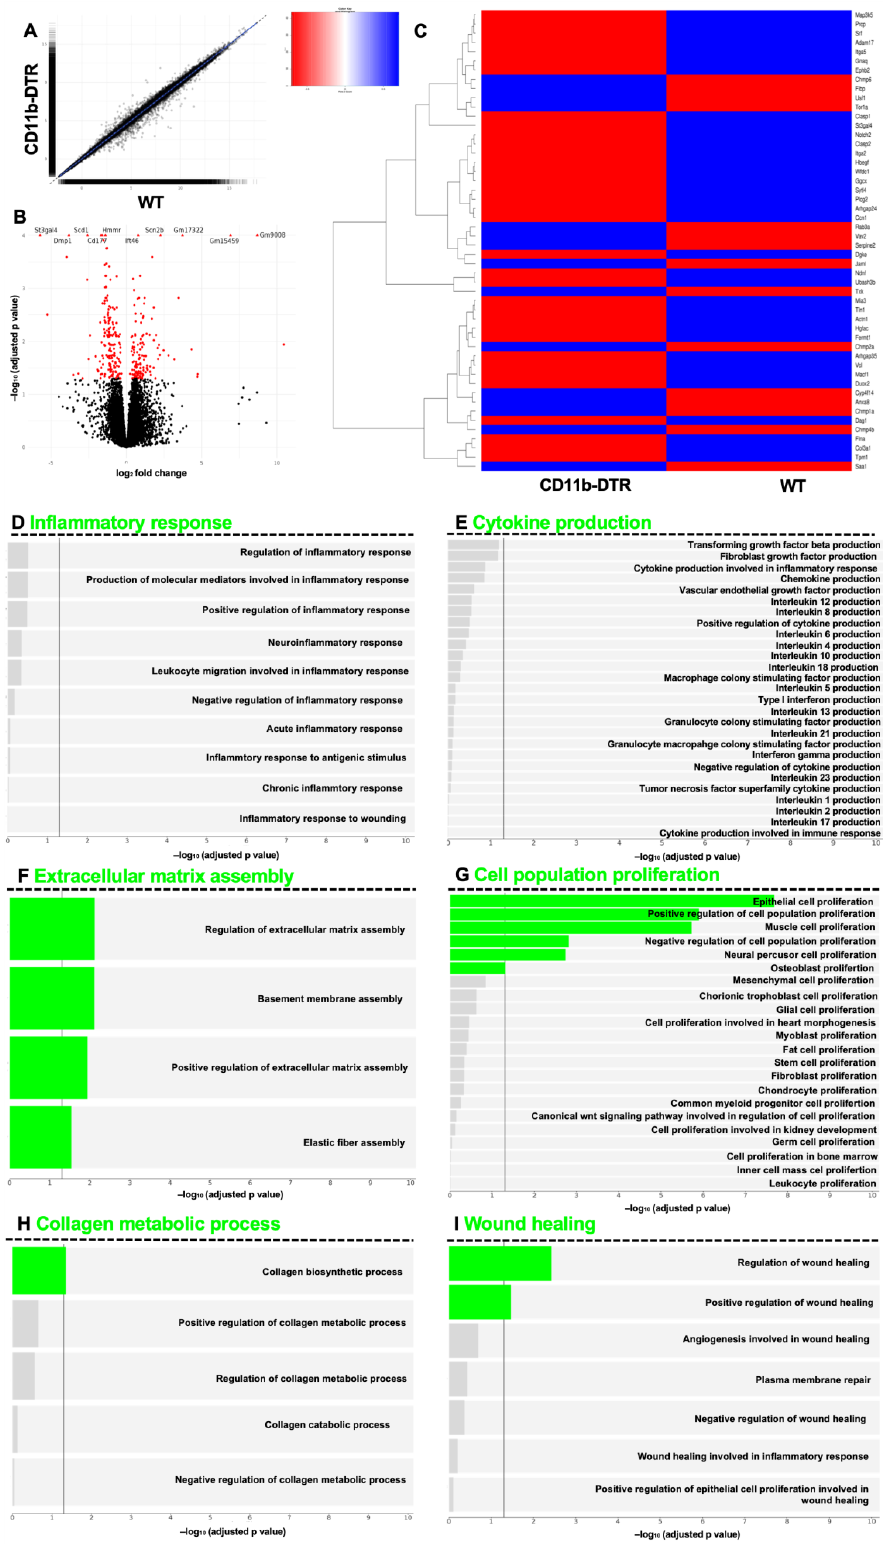
Figure 9. Gene set enrichment analysis of intestinal anastomotic healing during the reparative phase. Gene set enrichment analysis (GSEA) results of anastomotic healing (AH) comparing wild type (WT) with CD11b-diphtheria toxin receptor (DTR) mice. RNA-Seq was performed on samples collected at postoperative day 9. Scatterplot ( A ) and volcano plot ( B ). Volcano plot showing statistical